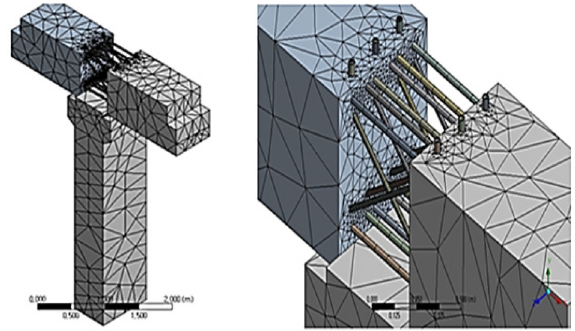
Fig. 24. Overall modeling and mesh shape